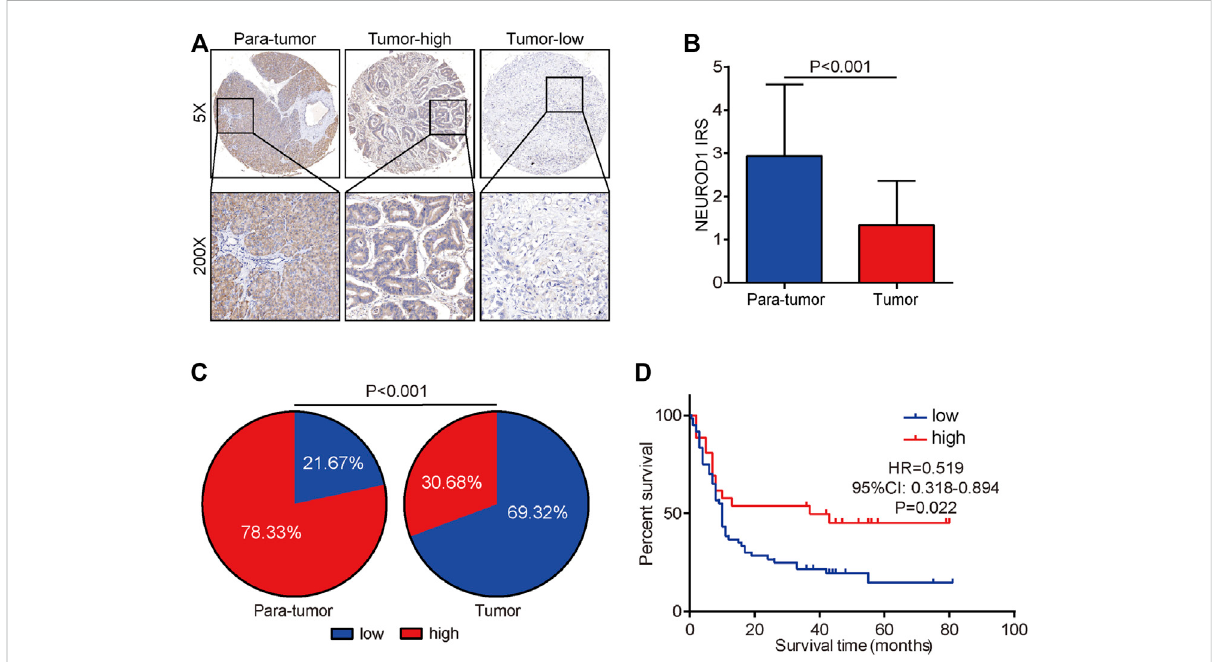
FIGURE 5 Expression and prognostic value of NEUROD1 protein in PaCa. (A) Representative microphotographs of NEUROD1 in tumor and para-tumor samples. Brown, NEUROD1. Blue, hematoxylin. Original magni fi cation: ×200. Samples with NEUROD1 IRS ≥ 2 were deemed to be the high- expression group, and the others were deemed to be the low-expression group. (B) The expression of NEUROD1 protein in PaCa tissues and para- tumor tissues. A signi fi cant decrease in NEUROD1 expression was observed in PaCa tissues. (C) NEUROD1 protein expression intensity proportion of PaCa tissues and para-tumor tissues. Low expression: IRS < 2; high expression: IRS ≥ 2. (D) Kaplan-Meier analysis of NEUROD1 in the HPanA150Su01 cohort. High NEUROD1 expression predicted better prognosis in PaCa patients.